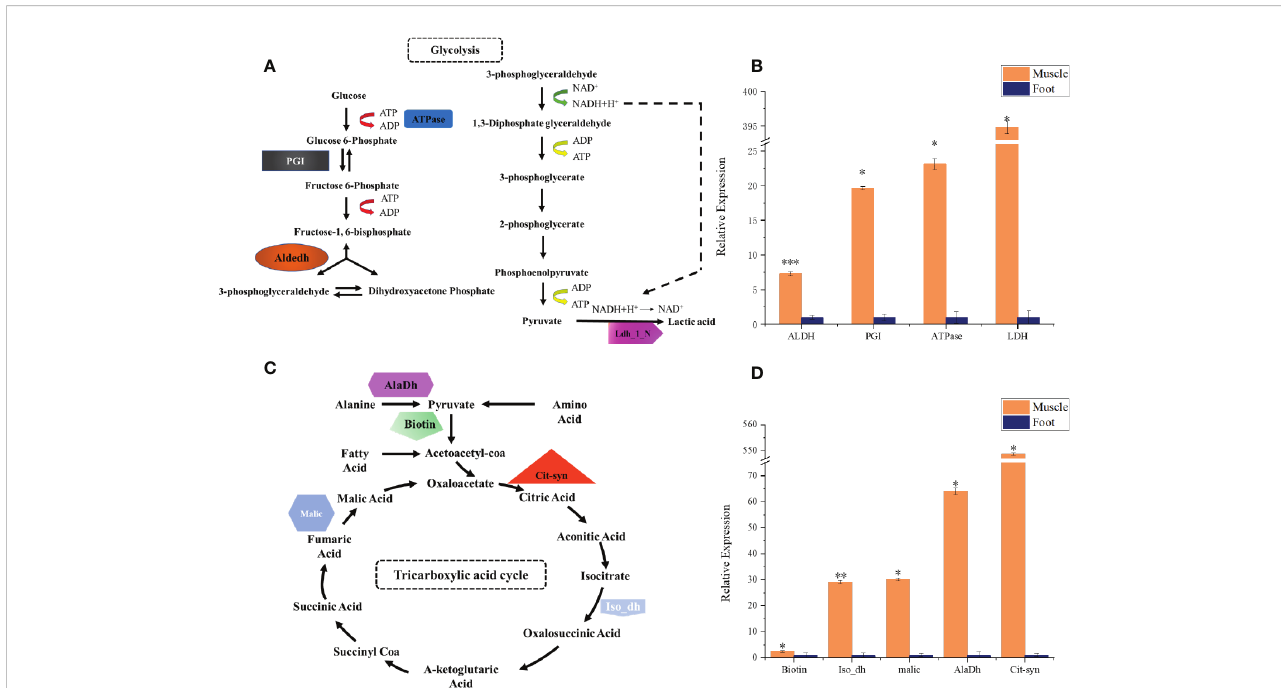
FIGURE 6 qPCR analysis of key energy metabolism-related genes in radular muscles and foot. (A) the glycolysis pathway and selected genes (B) qPCR analysis of aldehyde dehydrogenases (Aldedh), phosphoglucose isomerase (PGI), ATPase, and lactate dehydrogenase (Ldh_1_N) (C) the TCA cycle and selected genes (D) qPCR analysis of Biotin, isocitrate dehydrogenase (Iso_dH), Malic enzyme, alanine dehydrogenase (AlaDh), and citrate synthase (Cit-syn). All gene expressions are relative to the foot tissues. *P<0.05; **P<0.01; ***P<0.001,